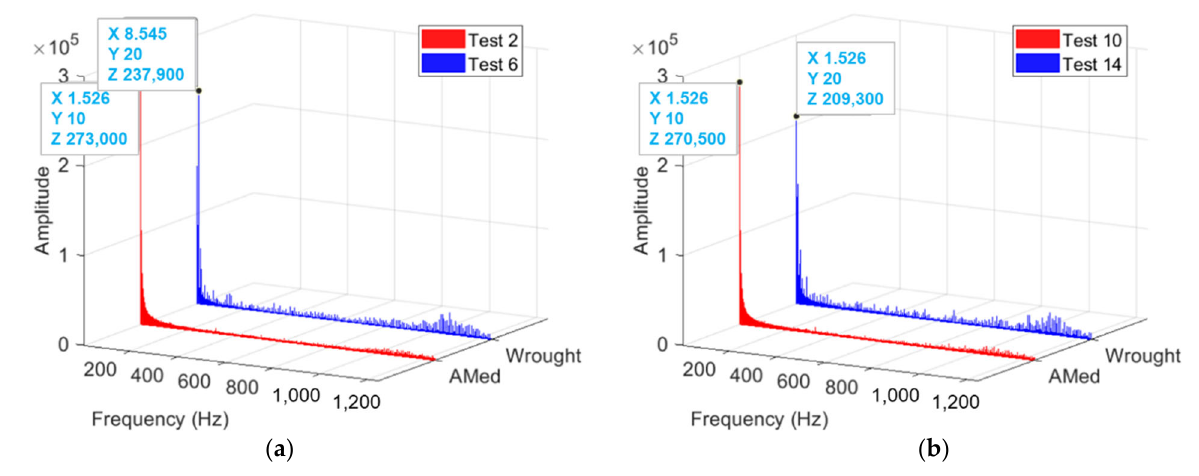
Figure 9. FFT of the signal of radial force when machining wrought and SLMed Ti6Al4V materials at the speed of 80 m/min and feed of 0.2 mm/rev: ( a ) at the cutting depth of 0.25 mm, ( b ) at the cutting depth of 0.5 mm.